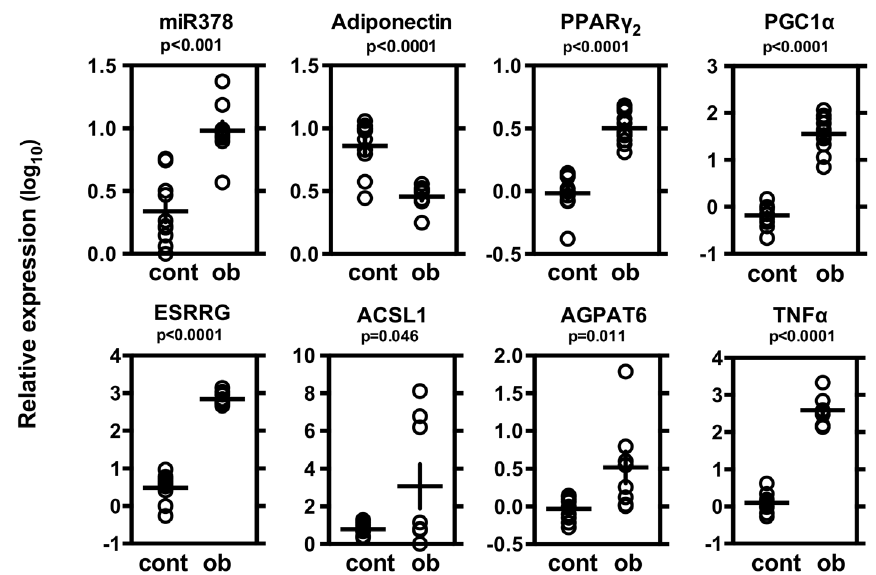
Figure 6. Levels of miRNA-378, adiponectin, PPAR c 2, PGC1 a , ESRRG, PGC1 b , ACSL1, AGPAT6 and TNF a in the adipose tissue of C57BL/6 and ob/ob mice. From normal C57BL/6 ( = , n=10) or diabetic ob/ob ( = , n=10) mice, epididymal adipose tissues were excised and used for gene expression analyses. Expression levels normalized to those of b -actin were log-transformed. Individual values are shown with mean 6 SE. p values were calculated by unpaired t-test.